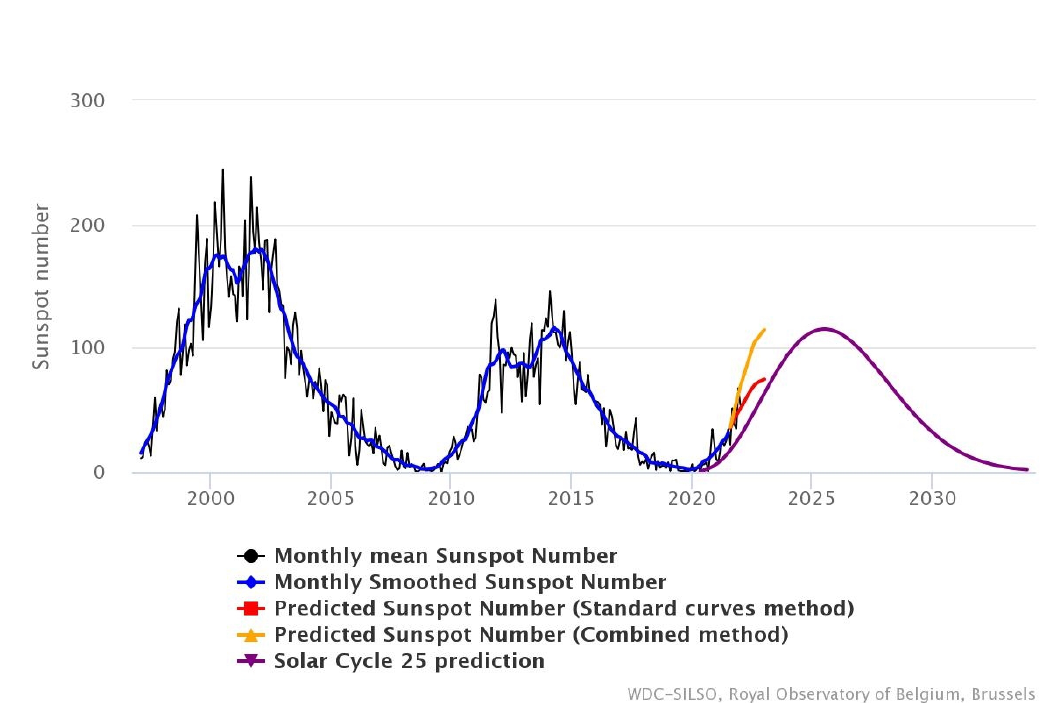
Figure 11. Solar cycle progression-Sunspot